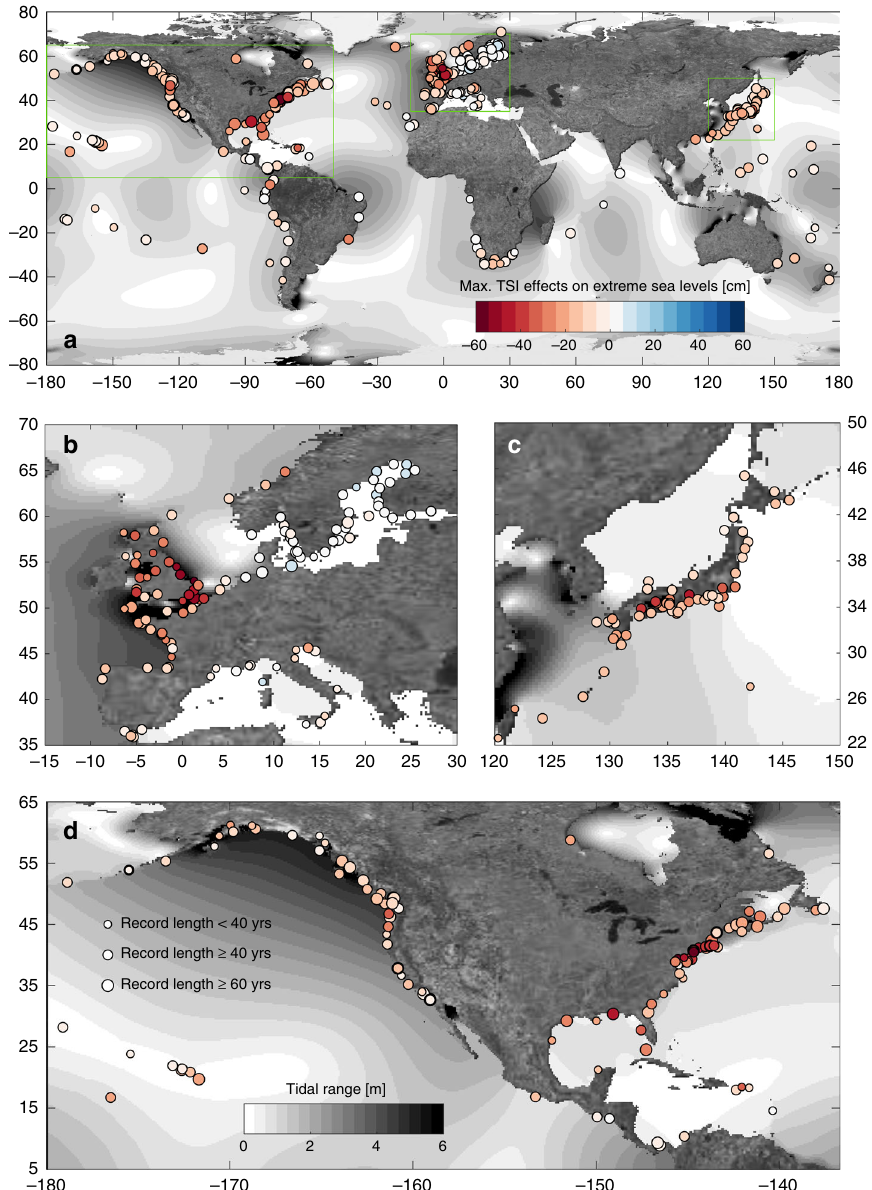
Fig. 2 Characteristics of tide and the dependence τ . The subpanels highlight dependencies between ( a ) tide at extreme sea level and non-linear effects, ( b ) dependence τ and non-linear effects, and ( c ) dependence τ and tide at extreme sea level. Non-linear effects <0 causes extreme sea level decreases and non-linear effects >0 increases. Sites dominated by the tide are de fi ned as having a tidal contribution >50%; at sites dominated by non-tidal residual, the non-tidal contribution is